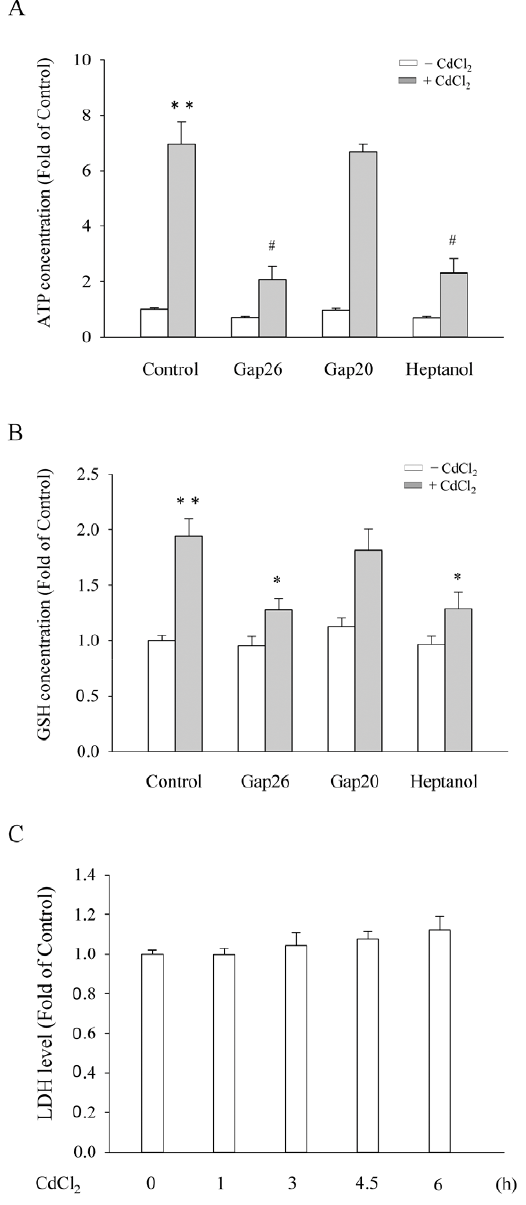
Figure 6. Blockade of Cd 2 + -induced ATP and GSH release by GJs inhibitor and Cx mimetic peptides. (A–B) Cx43-LLC-PK1 cells were pretreated with 4 mM heptanol for 30 min or with Cx43 mimetic peptides Gap20 and Gap26 at the concentration of 100 m M for 1 h, and then exposed to 35 m M Cd 2 + in the presence of the pretreated agents for additional 6 h ATP and GSH concentration in culture medium was measured. The data were expressed as the fold induction against basal level (mean 6 S.E., n=4). # p , 0.01 and * p , 0.05 versus Cd 2 + alone, and ** , 0.01 versus untreated control. (C) Time course effects of Cd 2 + on LDH release. Cx43-LLC-PK1 cells were treated with 35 m M CdCl 2 for the indicated duration. The supernatants were collected and assayed for LDH activity. The data were expressed as fold of zero point control (mean 6 S.E., n=4).